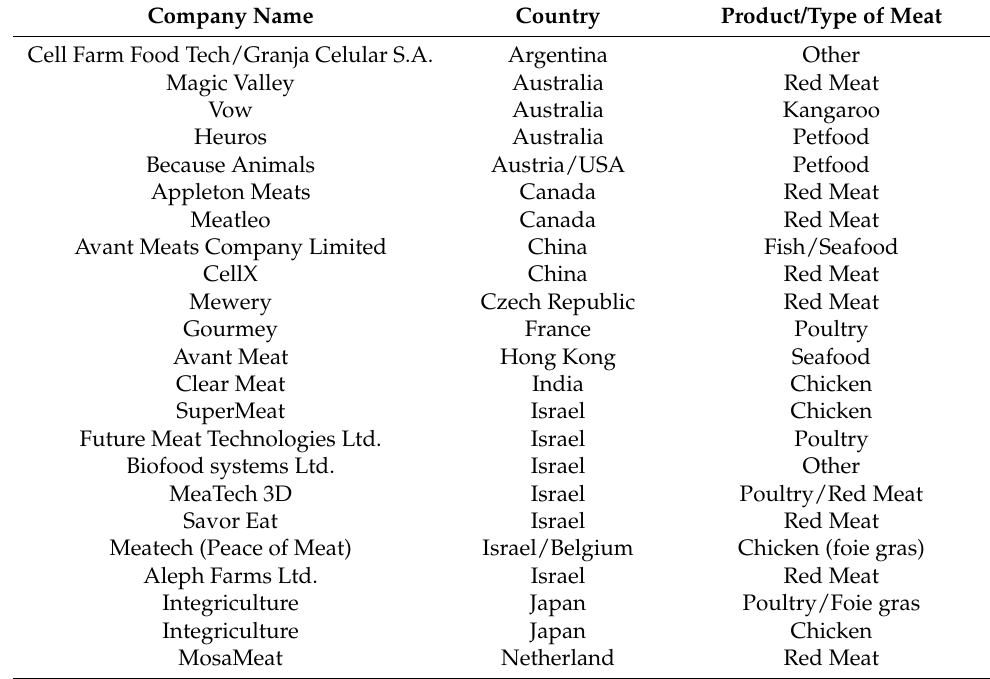
Table 2. Selected companies identified on the cultivated meat market from 2019–2022. Red meat means beef or/and pork, other means other types of meat/cells/media,